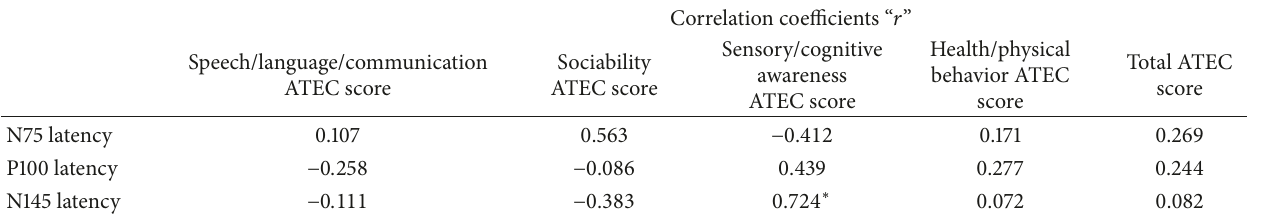
Table 4: A correlation analysis between the VEP parameters over the Oz electrode and the ATEC scores. Correlation coefficients “ 𝑟 ”